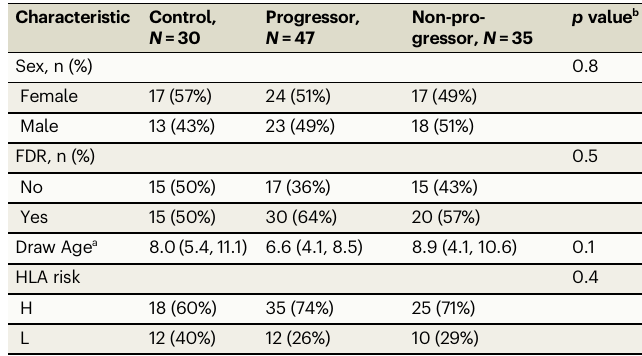
Table 2 | Clinical characteristics of participants of Diabetes Autoimmunity Study in the Young (DAISY) Study Characteristic Control, N =30